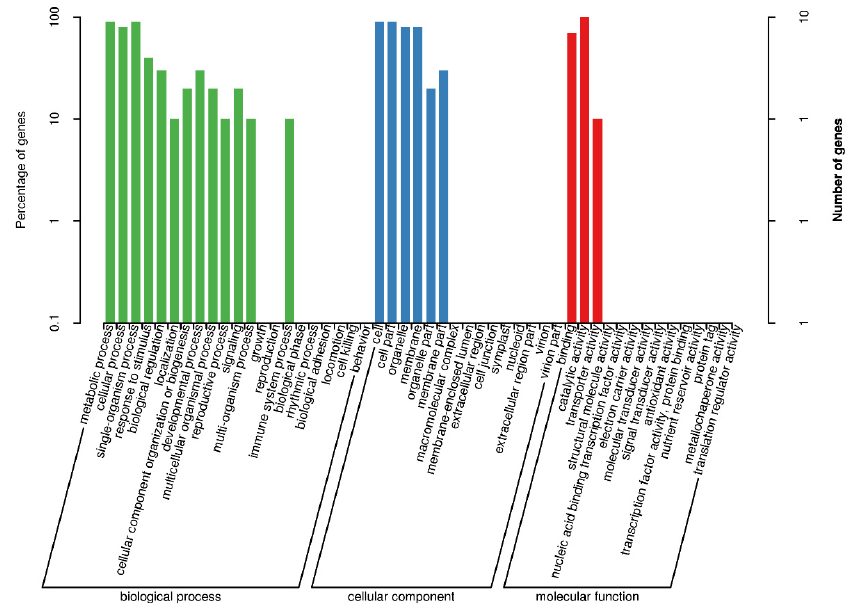
Figure 5. GO class of differentially expressed genes (DEGs) associated with Achnatherum inebrians according to the status of Epichloë endophytes and in different growing periods.